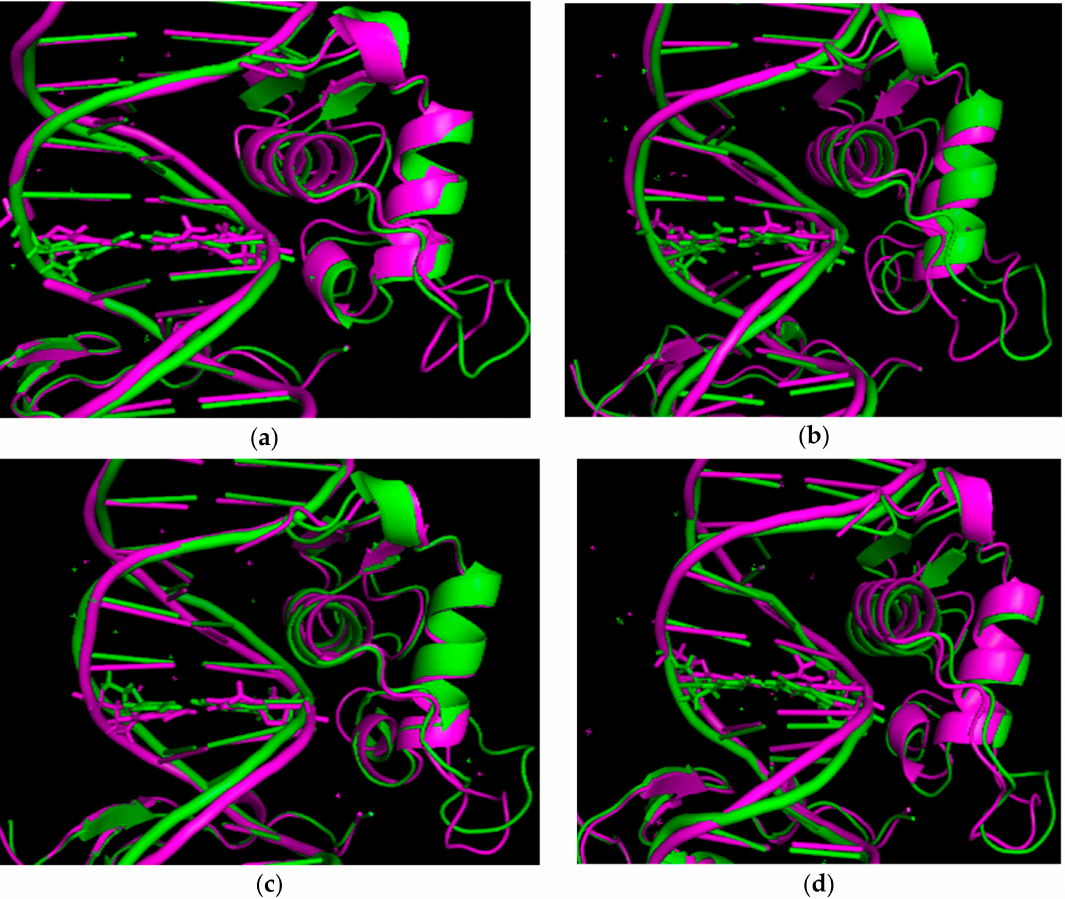
Figure 1. The ultimate frames of the molecular dynamics simulation of HNF-4 α DNA complexes: ( a ) Production run 1; ( b ) production run 2; ( c ) production run 3; and ( d ) production run 4. The wild-type complex is depicted in violet, and the complex containing the rSNP is depicted in green. The base pair that gets mutated is shown in sticks, while the remaining base pairs are represented as a